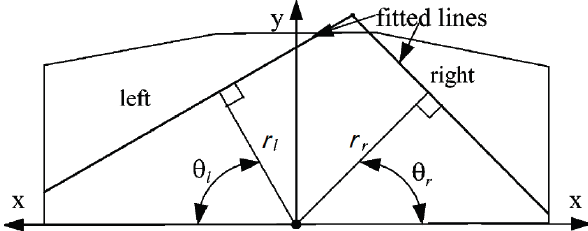
Figure 4. Flow chart of the forward vehicle candidate detection.